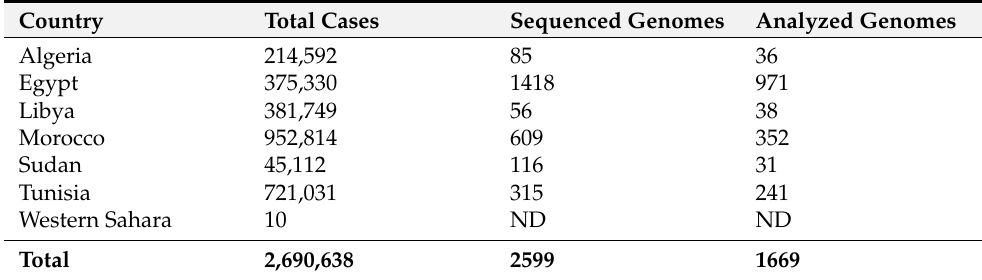
Table 1. COVID-19 cases distribution and total analyzed SARS-CoV-2 genomes from North African countries 1